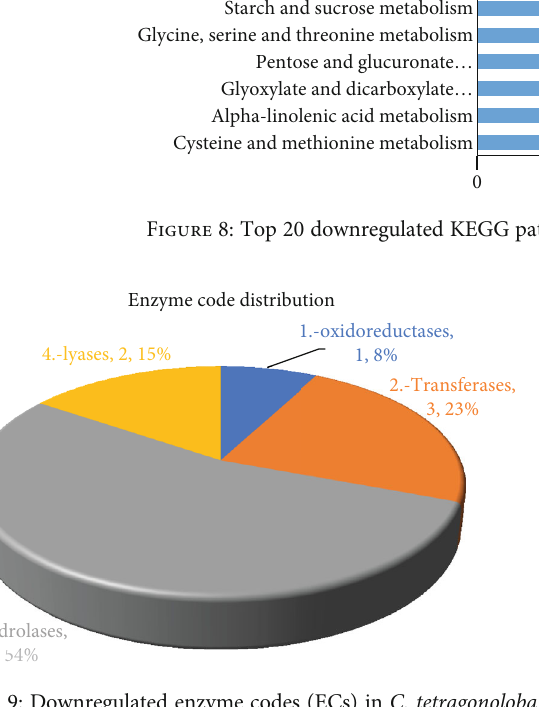
Figure 9: Downregulated enzyme codes (ECs) in C. tetragonoloba under drought stress.